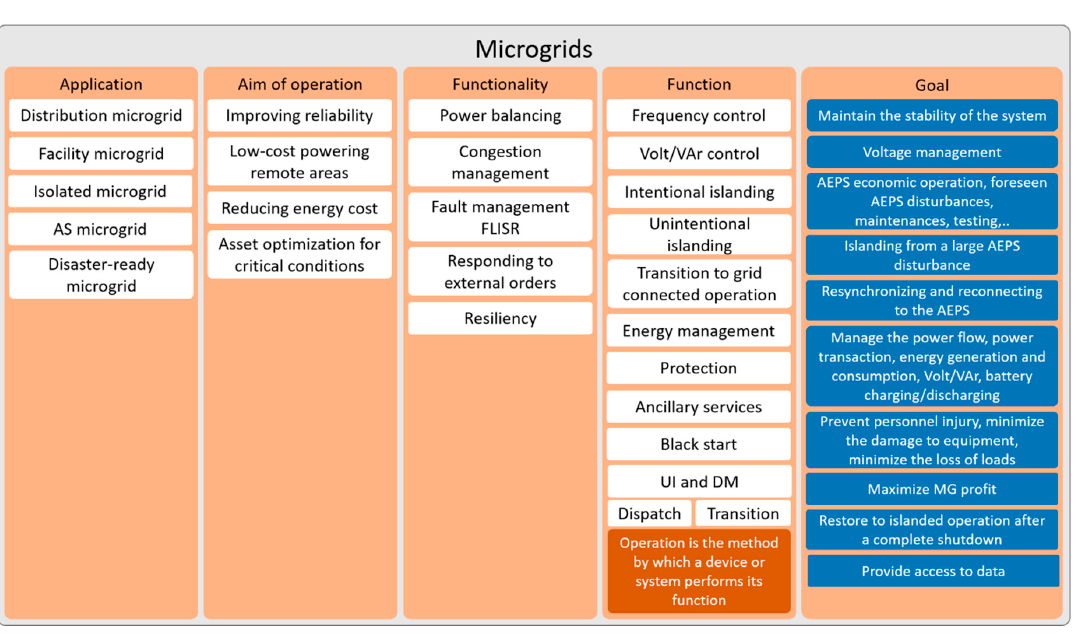
Figure 4. The functions of a microgrid management system.